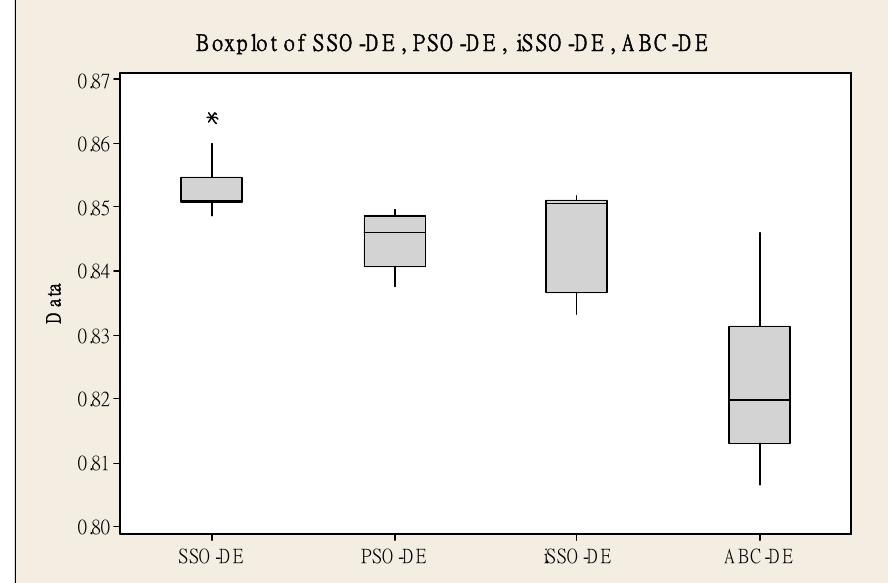
Figure 12. Box and whisker diagram for winter. *: Outliers.